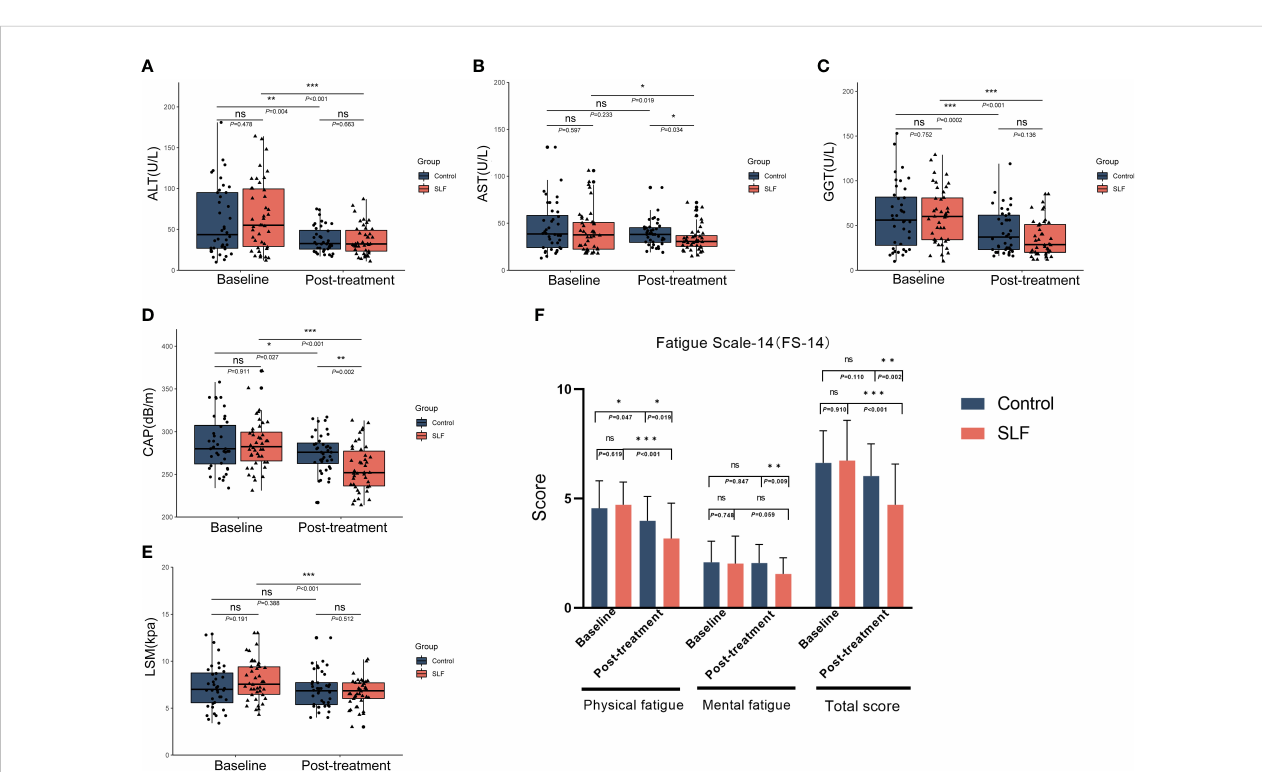
FIGURE 2 SLF had a clinical ef fi cacy on improving the liver function and FibroTouch, as well as relieving symptoms of fatigue. ALT, AST, GGT, CAP, LSM and FS-14 was compared in the two groups to evaluate the ef fi cacy of SLF in liver function and FibroTouch, as well as the symptoms of fatigue. (A) Comparison of ALT in the control group and SLF group. (B) Comparison of AST in the control group and SLF group. (C) Comparison of GGT in the control group and SLF group. (D) Comparison of CAP in the control group and SLF group. (E) Comparison of LSM in the control group and SLF group. (F) Comparison of FS-14 in the control group and SLF group. ALT, Alanine transaminase; AST, Aspartate aminotransferase; GGT, Gamma glutamyl transpeptidase; CAP, Controlled attenuation parameter; LSM, Liver stiffness measurement; FS-14, Fatigue scale-14. ns, no signi fi cance. * P < 0.05, ** P < 0.01 and *** P <